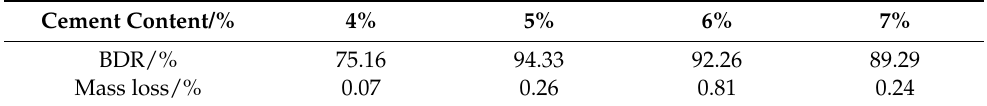
Table 12. Frost resistance